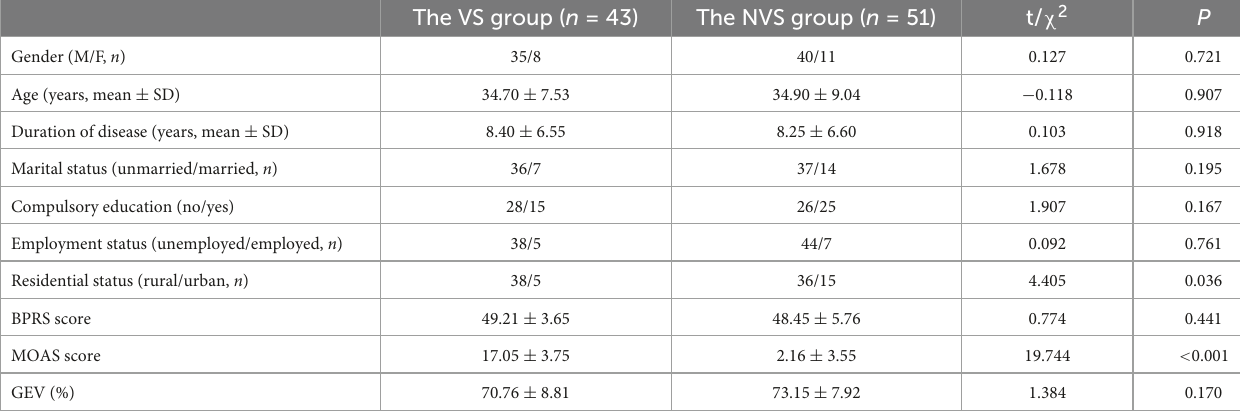
TABLE 1 Demographic and clinical characteristics of the VS and NVS groups.